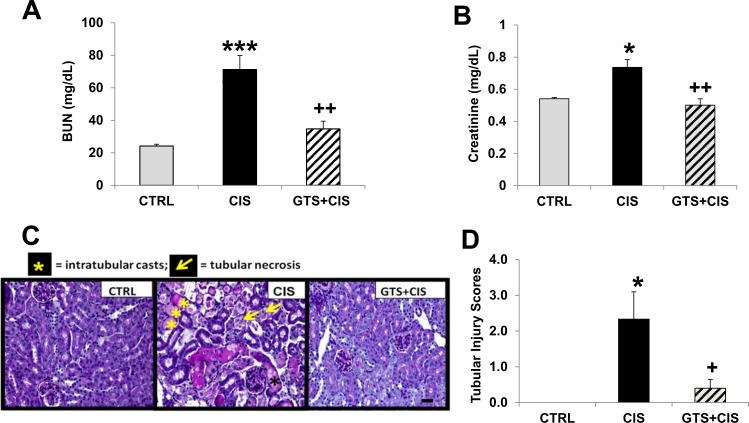
Cisplatin induces renal damage and GTS-21 exerts renoprotective effect.C57BL/6 mice (males, n = 8 mice per group) were injected daily for 4 days, prior to cisplatin (20 mg/kg, i.p.), with either saline (cisplatin only group, CIS) or GTS-21 (GTS-21 pretreatment group, GTS+CIS, 4mg/kg, i.p, twice) and until euthanasia 72hrs post-cisplatin. The control group (CTRL) received saline injections in place of GTS-21 or cisplatin. Kidney damage was assessed by measuring blood urea nitrogen (BUN, A) and plasma creatinine (B) levels. For tubular injury, fixed kidney tissues were stained with Periodic Acid Schiff reagent (PAS, C), scale bar, 50 μm; representative images for each group (x400) are shown and were scored for histological damage (0–4) (D). The scores were based on the percentage of tubules affected (0: <10%; 1: 10–25%; 2: 26–50%; 3: 51–75%; 4: >75%). Data are shown as mean ± SD. *** = p<0.001 vs. CTRL, * = p<0.05 vs. CTRL, ++ = p<0.01 vs. CIS, + = p<0.05 vs. CIS.